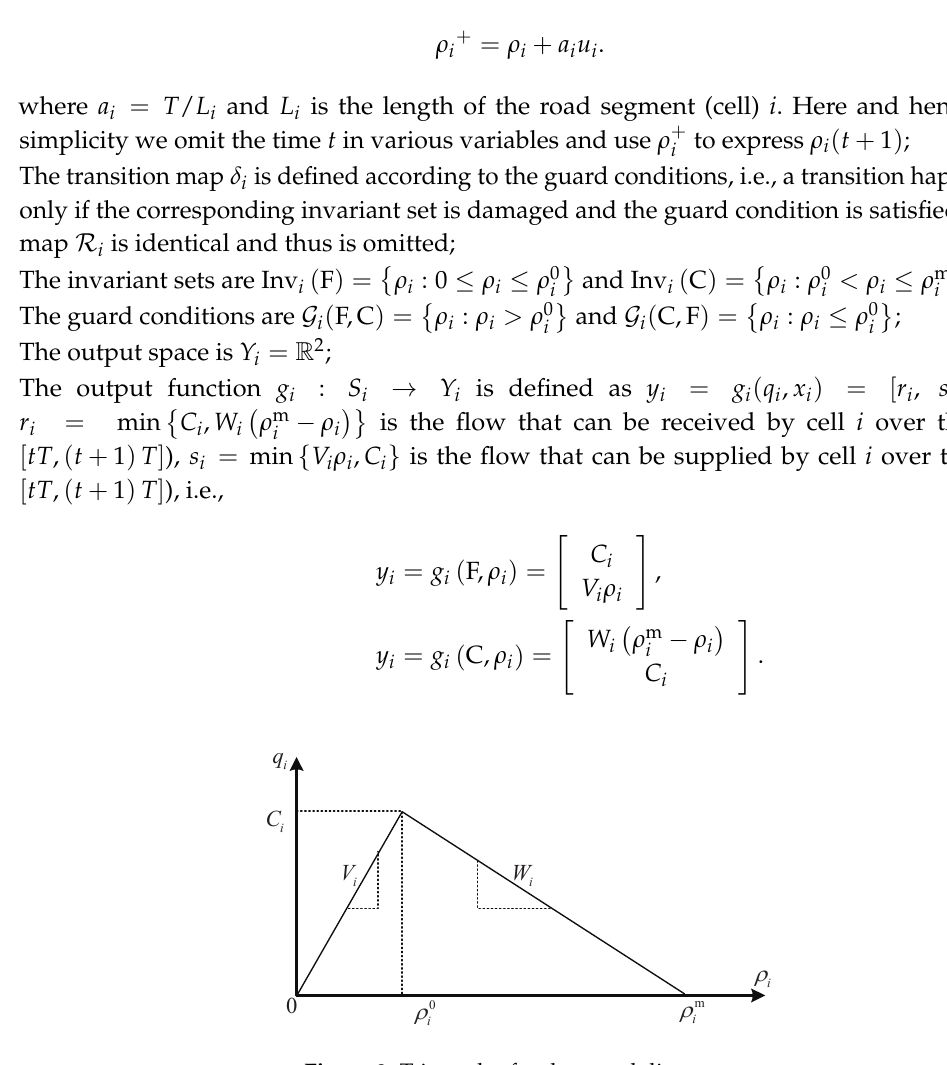
Figure 3. Triangular fundamental